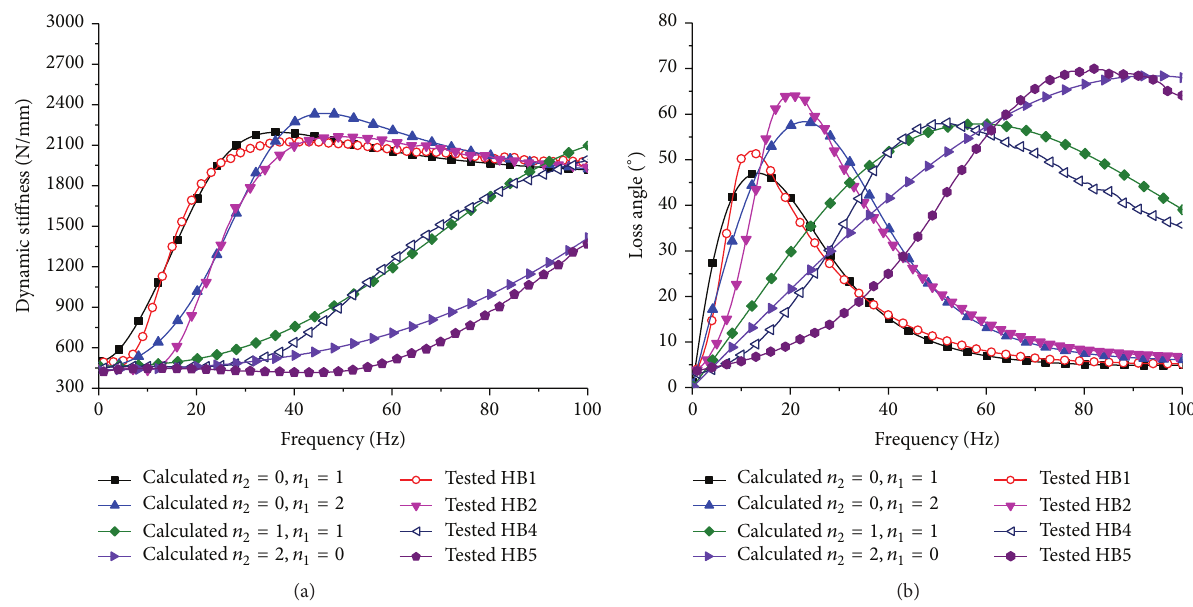
Figure 10: Dynamic performances of HDB (excitation amplitude: 0.8 mm). (a) Dynamic stiffness. (b) Loss angle.